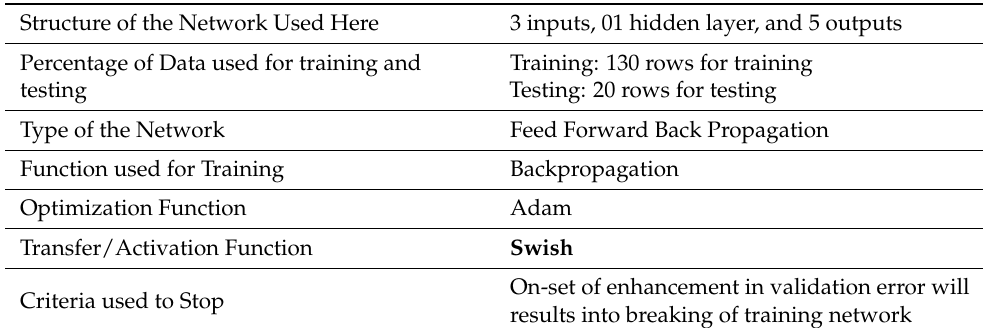
Table 4. Details related to the NN model used in this research.